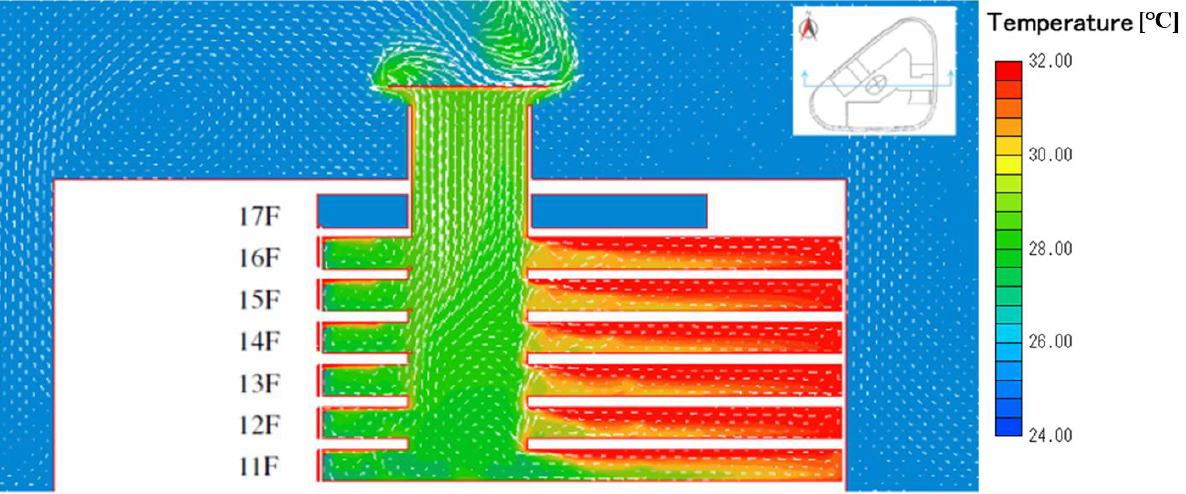
Figure 15. Temperature distribution with ambient temperature at 30 °C. Table 8. Thermal parameters at various ambient temperatures. Items